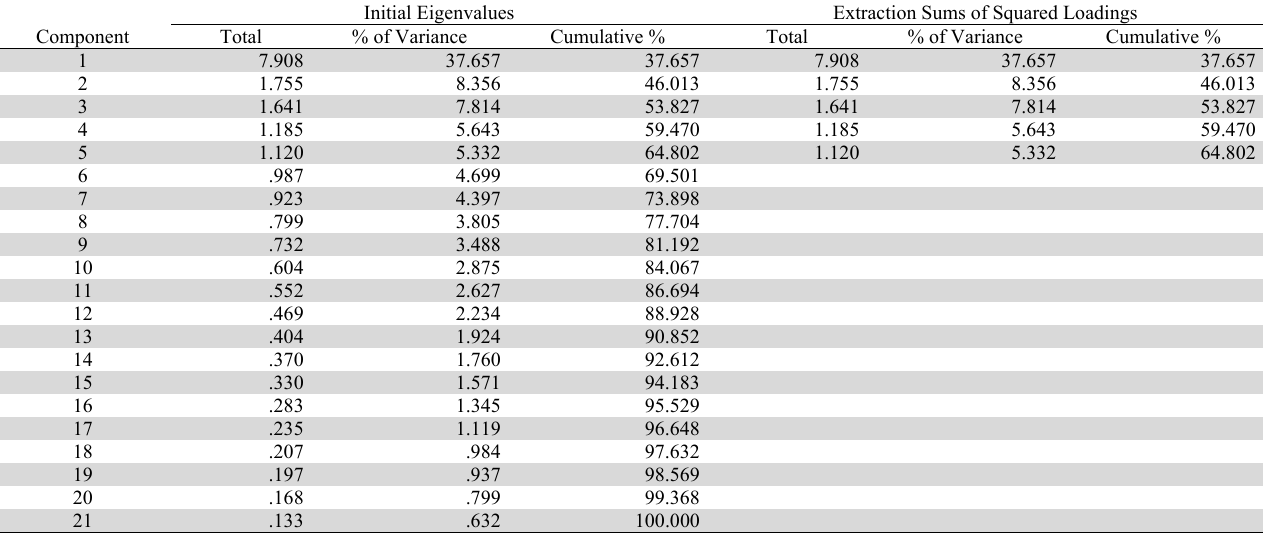
Note: Extraction Method is Principal Component